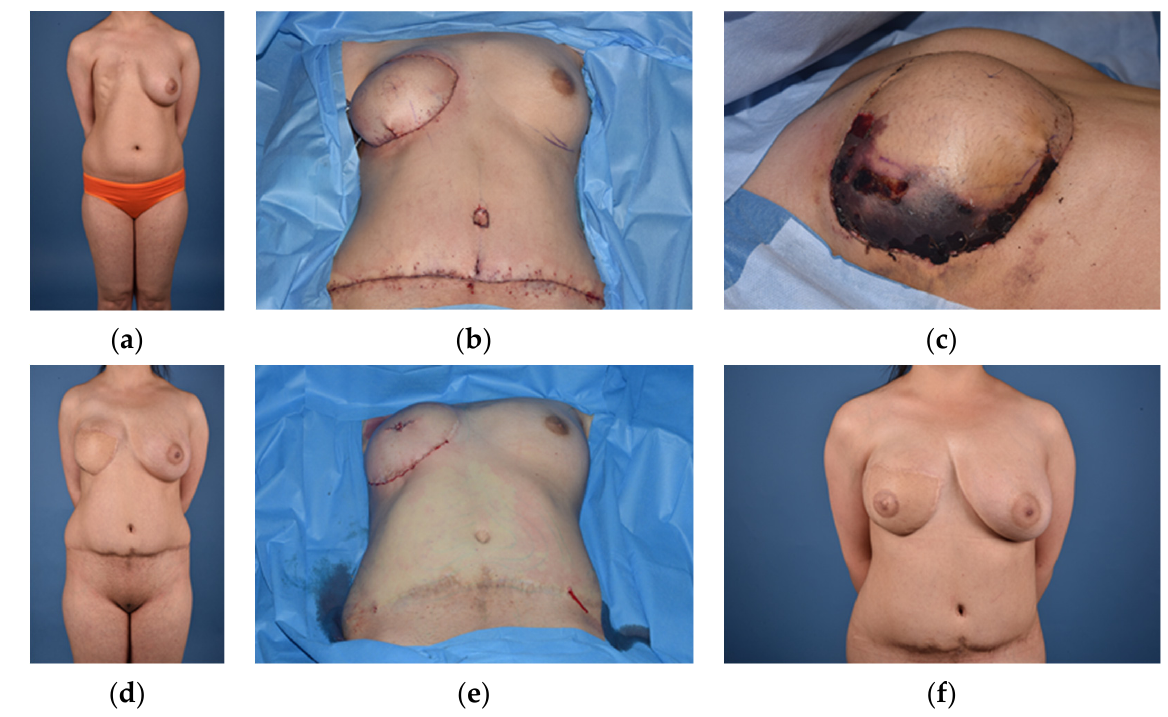
Figure 4. ( a ) = Female patient (24) with severe deformity and absence of breast and areola preoperatively; ( b ) = Postoperative image after DIEP flap reconstruction; ( c ) = Partial lateral necrosis of the flap; ( d ) = 3 months after flap reconstruction and necrectomy; ( e ) = Form correction of the breast, nipple reconstruction (arrow flap) and lipofilling (220 mL) after 13 months; ( f ) = Final result 21 months after DIEP flap, (areola tattoo after 15 months).